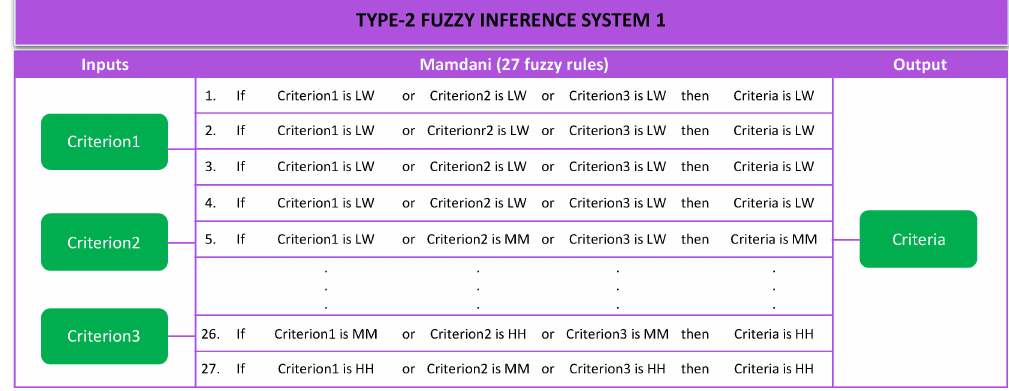
Figure 8. Type-2 fuzzy criteria integration.